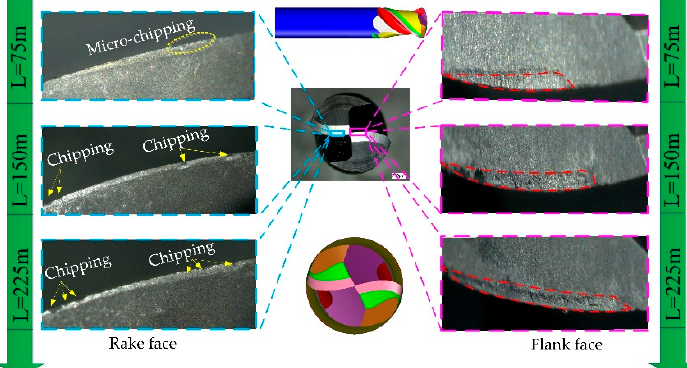
Figure 14. Tool wear morphology of the revolving cycloid milling cutter with different milling lengths.